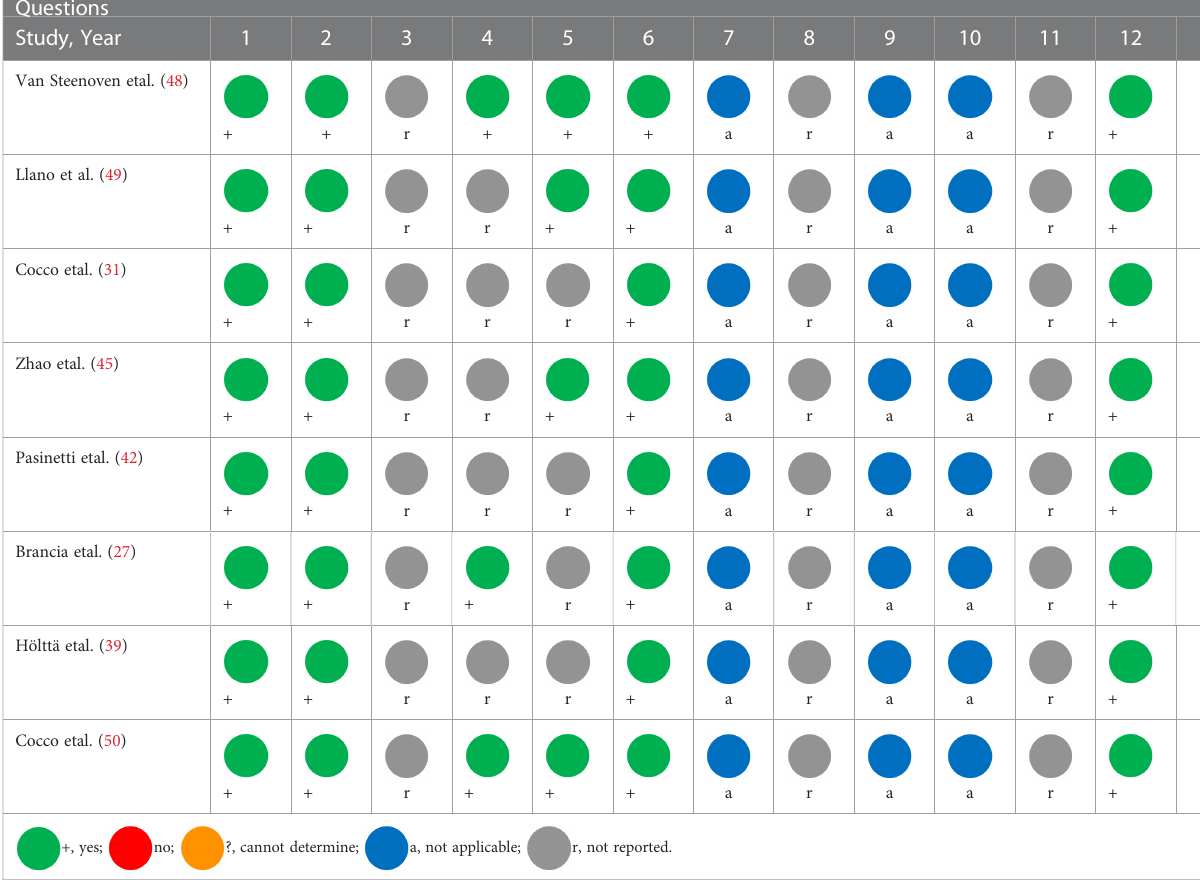
TABLE 4 NHLBI tool for quality assessment of the included studies.